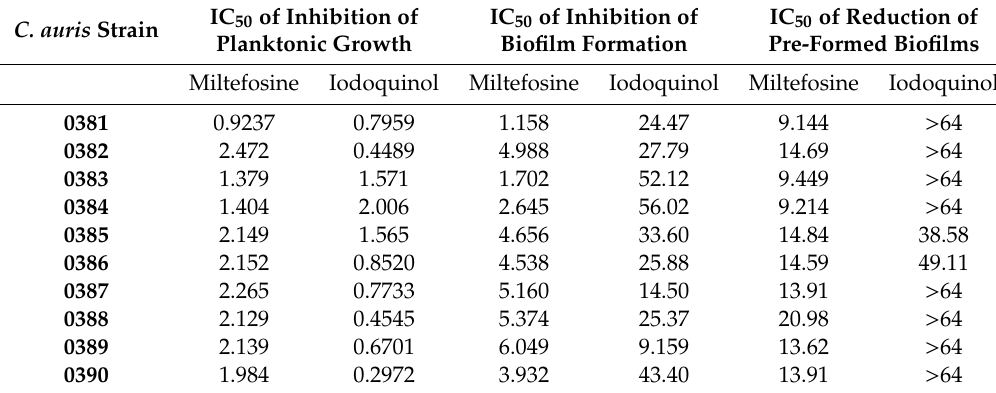
Table 2. Calculated IC 50 values for the two main repositionable compounds miltefosine and iodoquinol against di ff erent C. auris strains from the CDC panel, under the three di ff erent growing conditions: inhibition of planktonic growth, inhibition of biofilm formation, and activity against preformed biofilms. Values are in µ g /